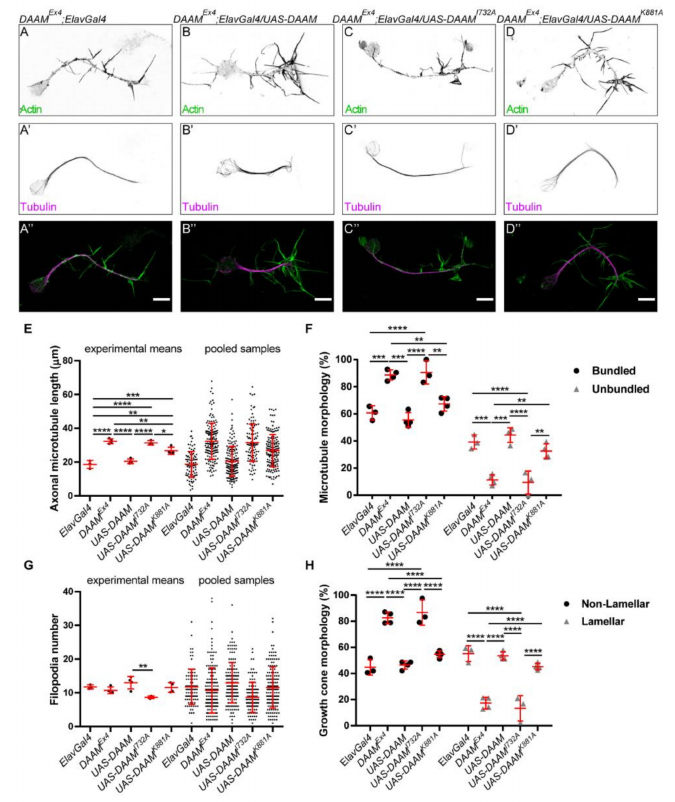
Figure 5. The actin-processing activity of DAAM plays a role in axon development in primary neurons. ( A – D (cid:48)(cid:48) ) Representative images of the axonal and growth cone morphology of primary neurons derived from DAAM Ex4 ;Elav-Gal4 control ( A – A (cid:48)(cid:48) ) and transgene expressing ( B – B (cid:48)(cid:48) - DAAM ; C – C (cid:48)(cid:48) - DAAM I732A ; D – D (cid:48)(cid:48) - DAAM K881A ) Drosophila embryos. The actin cytoskeleton was labelled by phalloidin (green), and microtubules were detected by an anti-tubulin antibody (magenta). Scale bar represents 5 µ m. ( E ) Statistical analysis of the length of the axonal microtubule bundles. Scatter plots show the values of the individual cells and the means of the independent experiments. ( F ) Scatter plots show the frequency of microtubule morphologies in the growth cone. ( G ) Statistical analysis of the axonal filopodia numbers. Scatter plots represent the values of the individual cells and the means of the independent experiments. ( H ) Scatter plots show the frequency of growth cone morphologies labelled by phalloidin. ANOVA was used for statistical analysis. Tukey’s post hoc test was used for multiple comparison. * p < 0.05, ** p < 0.01, *** p < 0.001, **** p <